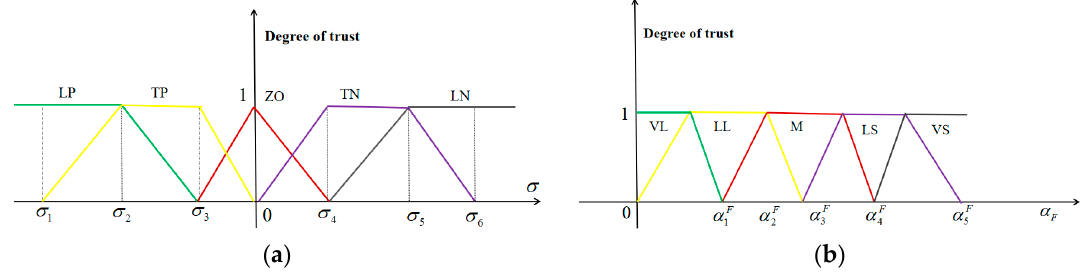
Figure 2. Curves for the Membership functions. ( a ) Reward/Input membership function. ( b ) Learning rate/Output membership function.